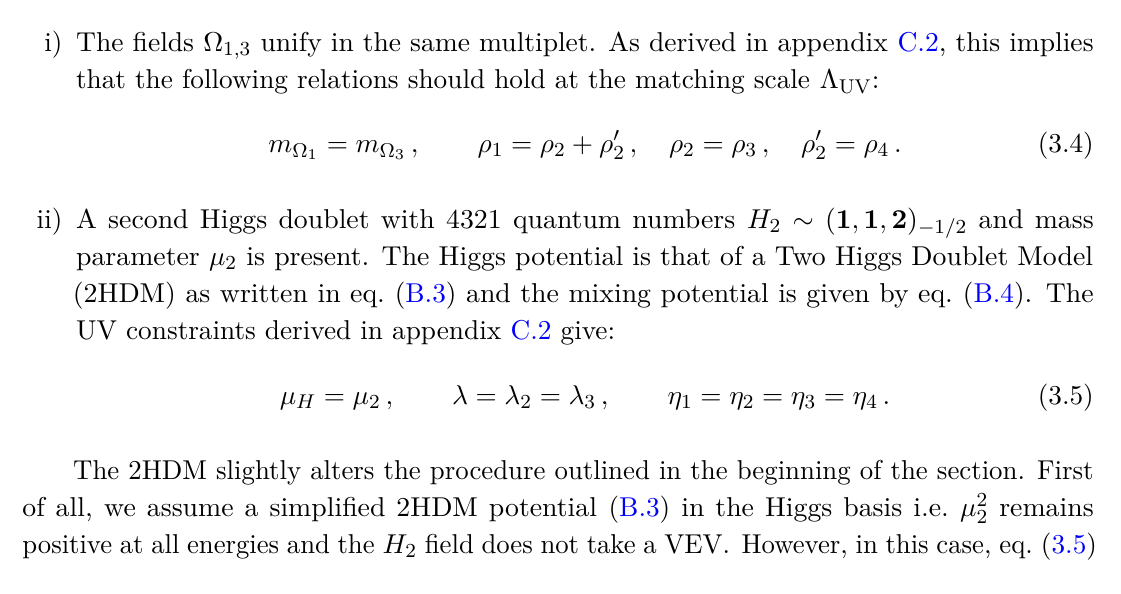
(evaluated at the IR scale µ = m ) to small h phys eff mixing couplings (left) and the Ω quartic couplings (right) at 1 , 3 1 , 3 that reproduces the measured Higgs mass is shown eff fails to radiatively trigger EWSB is shaded in eff